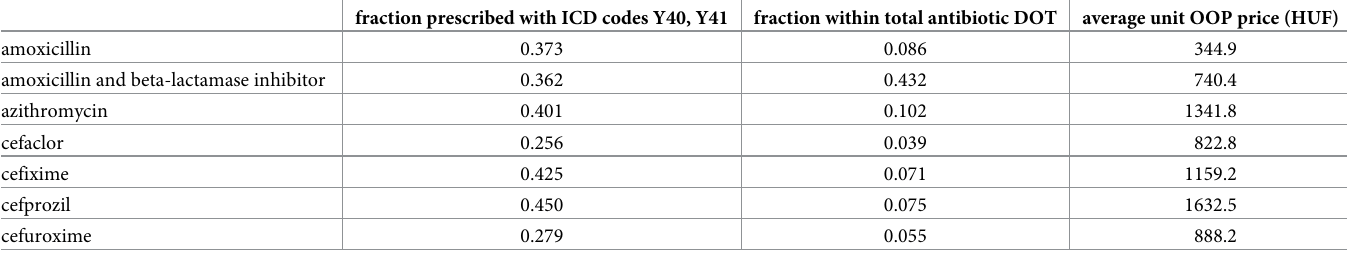
Table 1. Prescription patterns by ATC groups, ages 0-4, August 2016-February